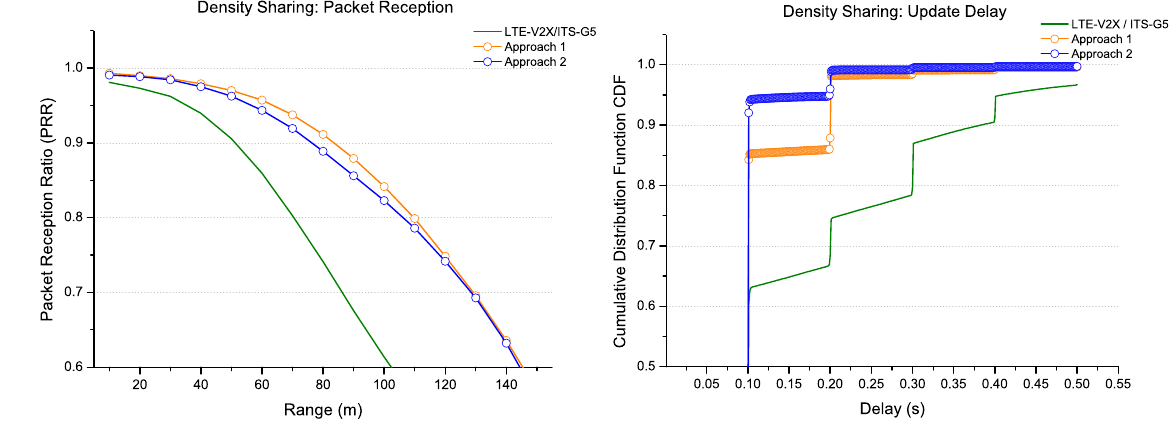
Figure 16. Coexistence LTE-V2X/ITS-G5: density sharing for packet size 1200